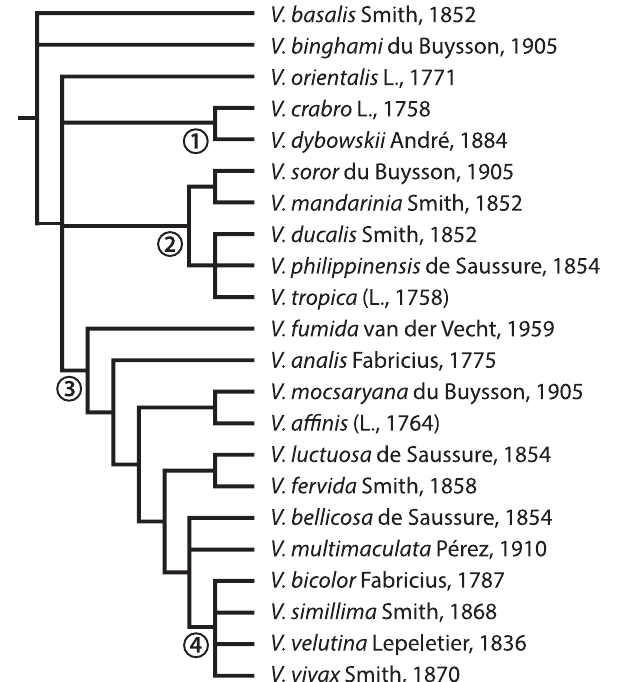
Figure 1. Phylogeny of the genus Vespa after Archer (1994a: figure 8). Tree updated for the current classification (Nguyen et al. 2006). The species groups discussed in this paper are as follows: 1 crabro 2 tropica 3 affinis 4 bicolor sensu Archer